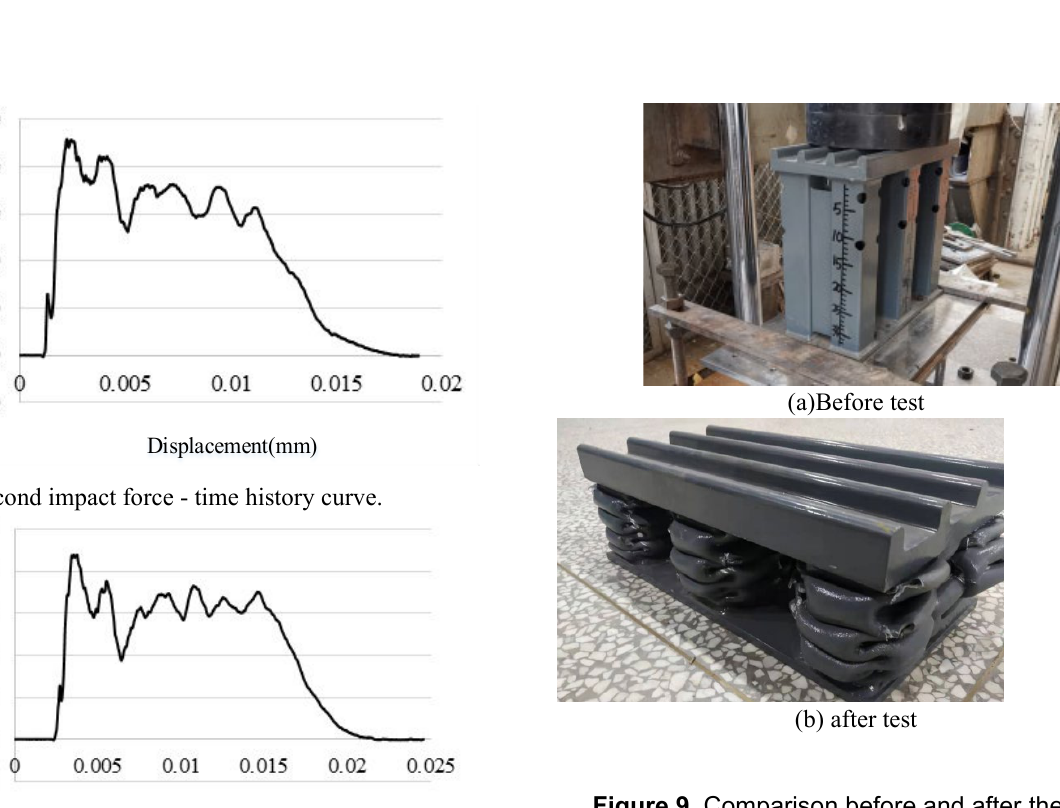
Figure 9. Comparison before and after the anti- climbing device